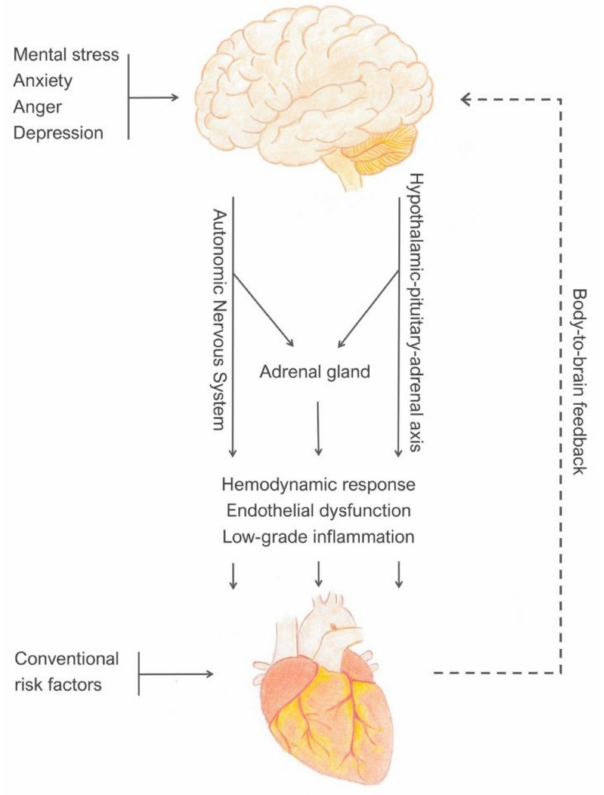
Figure 1. Brain-to-body and body-to-brain control of autonomic, neuroendocrine, and immune responses to mental